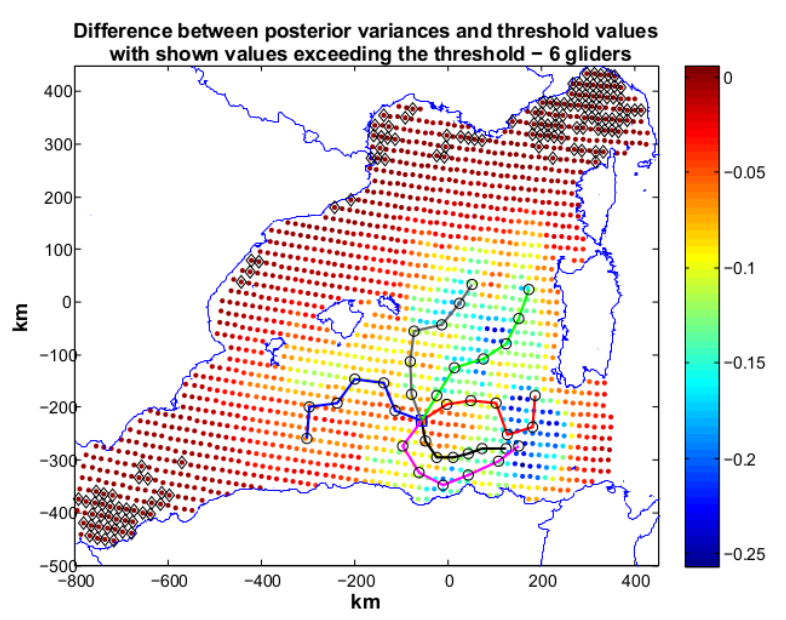
Figure 10. Scenario 3: planned paths for six gliders. The solution is characterized by J η = 0.14 and J c = 2. In the figure we show also the difference between posterior variances and relative values of the objective threshold. Black markers indicate posteriors that gliders did not succeed in lowering enough. These locations are limited in number showing the optimization has found an acceptable solution to the